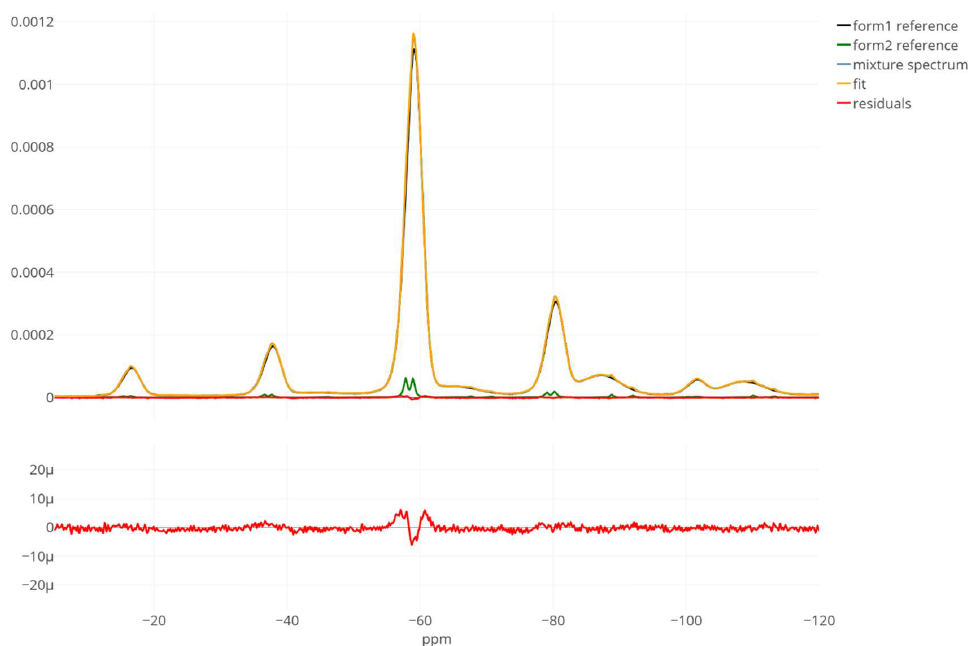
Figure 5. A satisfactory model fit obtained with the automated “proportion and processing parameters” mode. The true proportion of the crystalline spectrum (“form2 reference”, the green line) in the mixture (the blue line) spectrum is 3%, whereas the model estimate points at 2.84%, yielding a −5.5 relative error (in percentage points). The bottom panel is a zoomed view on the residual line alone that confirms the good quality of the found solution. Only spectrum real parts are shown. The x-axis range was limited to −5 and −120 ppm for better visibility.